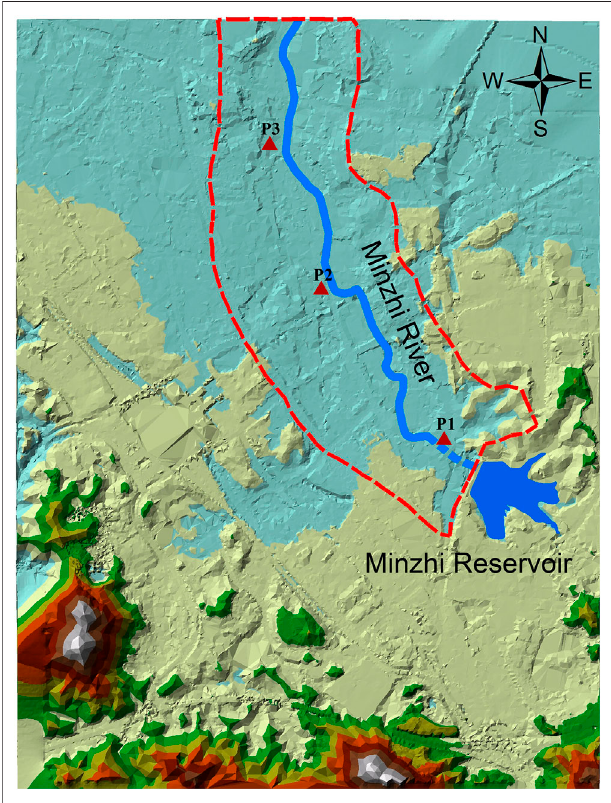
FIGURE 1 | Location of the study area and the three typical positions: P1, P2, and P3.